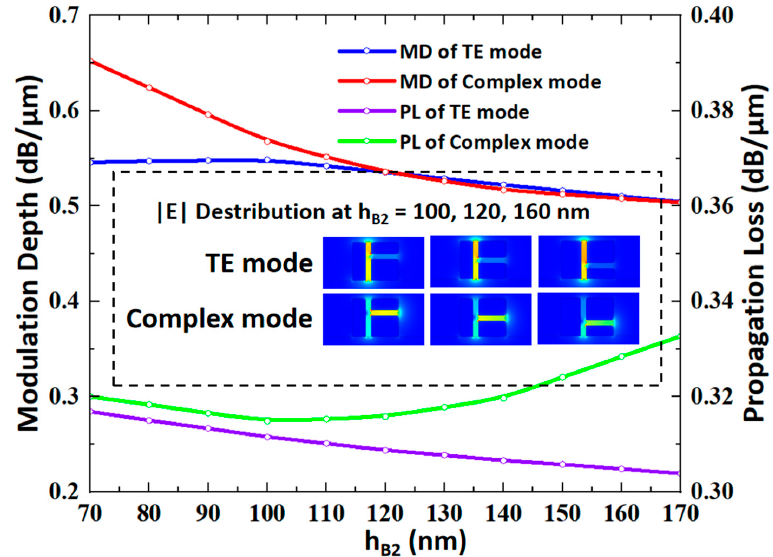
Figure 14. Re( N eff ) as a changing relationship of h B2 for ( a ) TE mode and ( b ) complex mode.